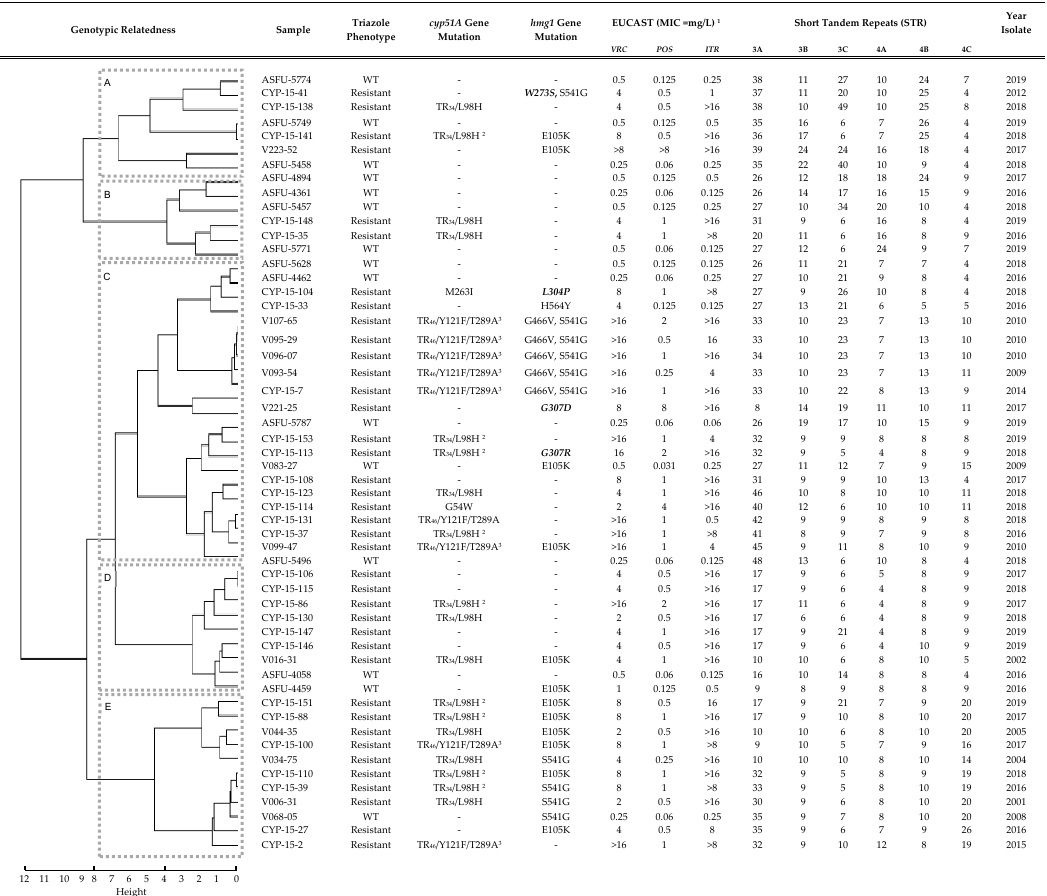
Table 1. Characteristics and Genetic Relatedness of Aspergillus fumigatus Clinical Isolates Harboring hmg1 Gene Mutations and of Selected Isolates without hmg1 Gene Mutations.